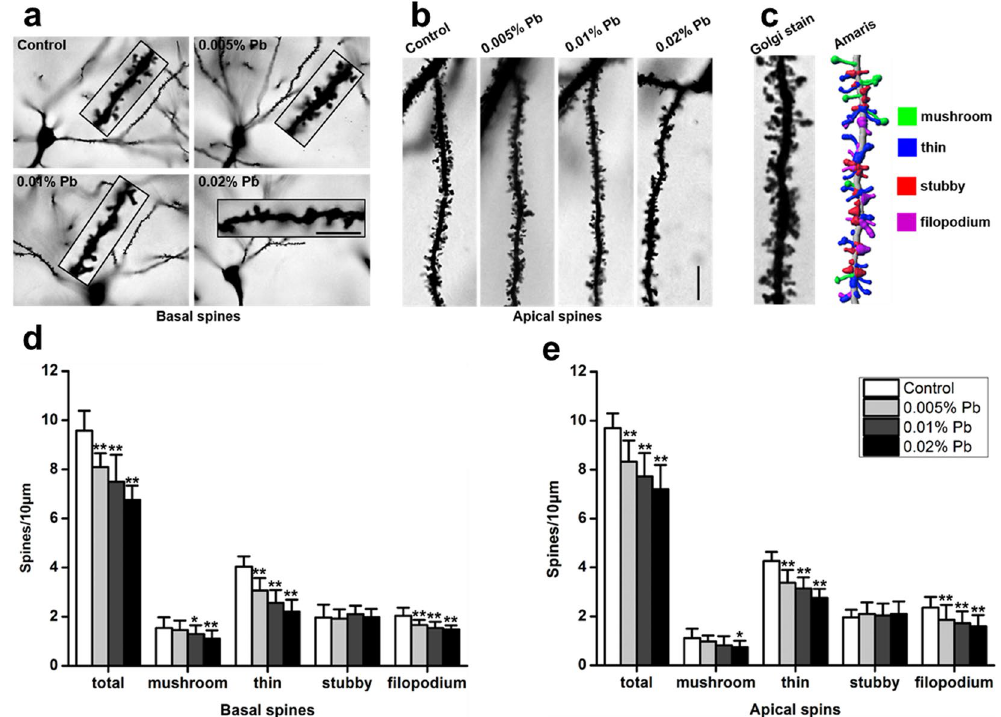
Figure 4. Pb exposure reduced the density of dendritic spines of pyramidal neurons in PND30 rats. ( a ) Golgi staining of basal spines, scale bars = 5 μ m. ( b ) Golgi staining of apical spines, scale bars = 10 μ m. ( c ) Imaris reconstruction of spines. ( d ) Statistic analysis of the effect of Pb exposure on basal spines (16 neurons/8 rats for all groups). ( e ) Statistic analysis of the effect of Pb exposure on apical spines (16 neurons/8 rats for all groups). Data are expressed as mean ± SD of spines per 10 μ m for all groups of rats, * p < 0.05, ** p < 0.01.